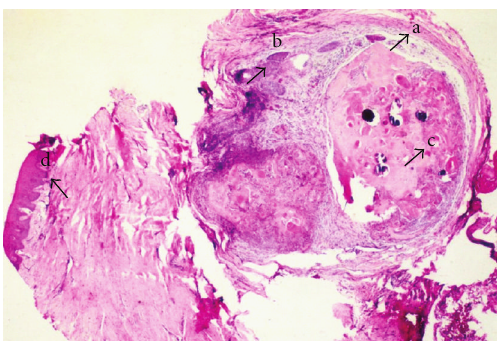
Figure 2: Solid wellcircumscribed encapsulated mass (a) showing ameloblastomatous islands of odontogenic epithelium (b) and ghost cells (c) with overlying epithelium (d) [Hematoxylin and Eosin, × 4].